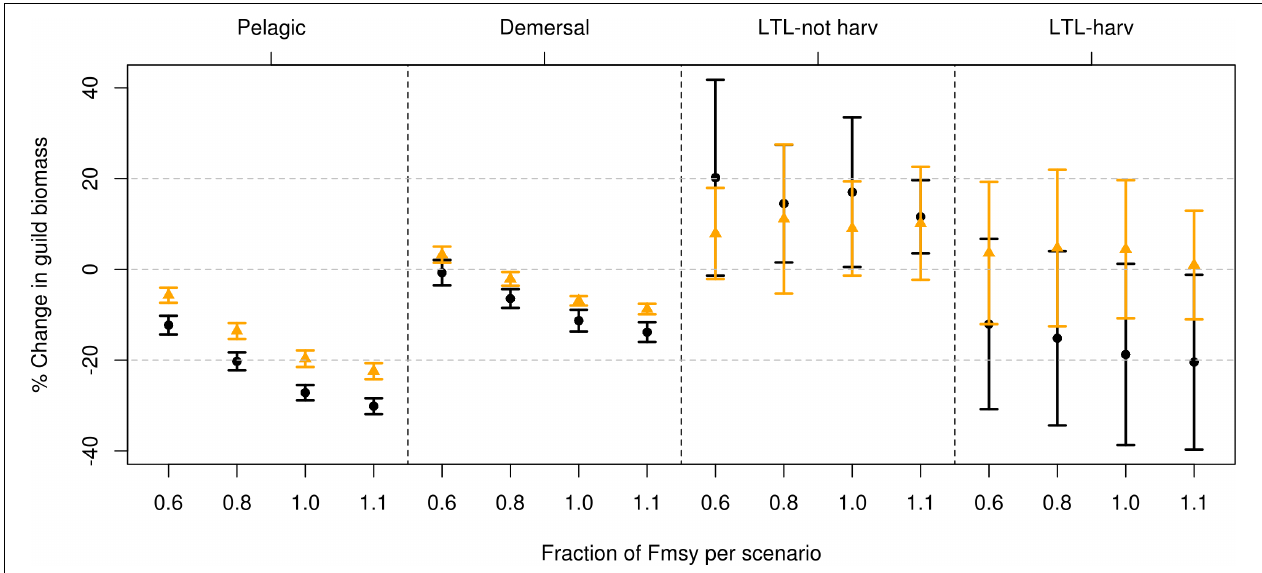
FIGURE 2 | Change in guild biomass (%) between future (2055–2065) scenarios compared to historic scenarios (2005–2015). The dots represent the average difference for all components included in the guild, lines represent one standard deviation, resulting from the 14 replicates. There are eight sets of simulations within each guild, where orange dots and lines represent harvest of the large commercial components only and black includes harvest of the large commercial components plus the five additional components. The fraction of Fmsy for each scenario is indicated on the x -axis for each guild. The demersal guild includes cod, haddock, Greenland halibut, golden redfish, beaked redfish, and the functional groups “other demersals” and “large demersals.” The pelagic guild includes mackerel, blue whiting, herring, capelin and polar cod. LTL-harv are the lower trophic levels that are being harvested: mesozooplankton, prawns and mesopelagic fish, whereas LTL-not harv are the lower trophic levels not being harvested: jellyfish, small and large